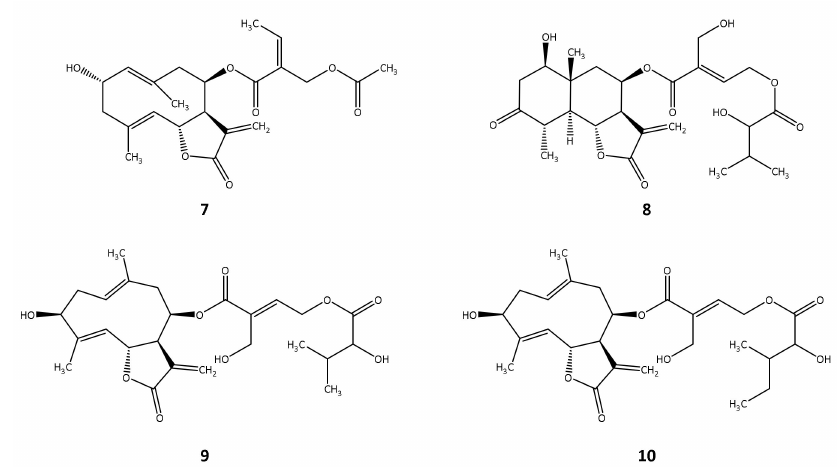
Figure 2. Chemical structures of the STLs tested in